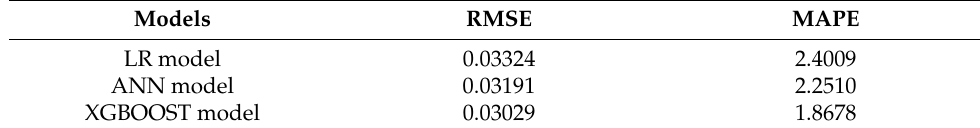
Table 7. The RMSE and MAPE of the three steam consumption models.